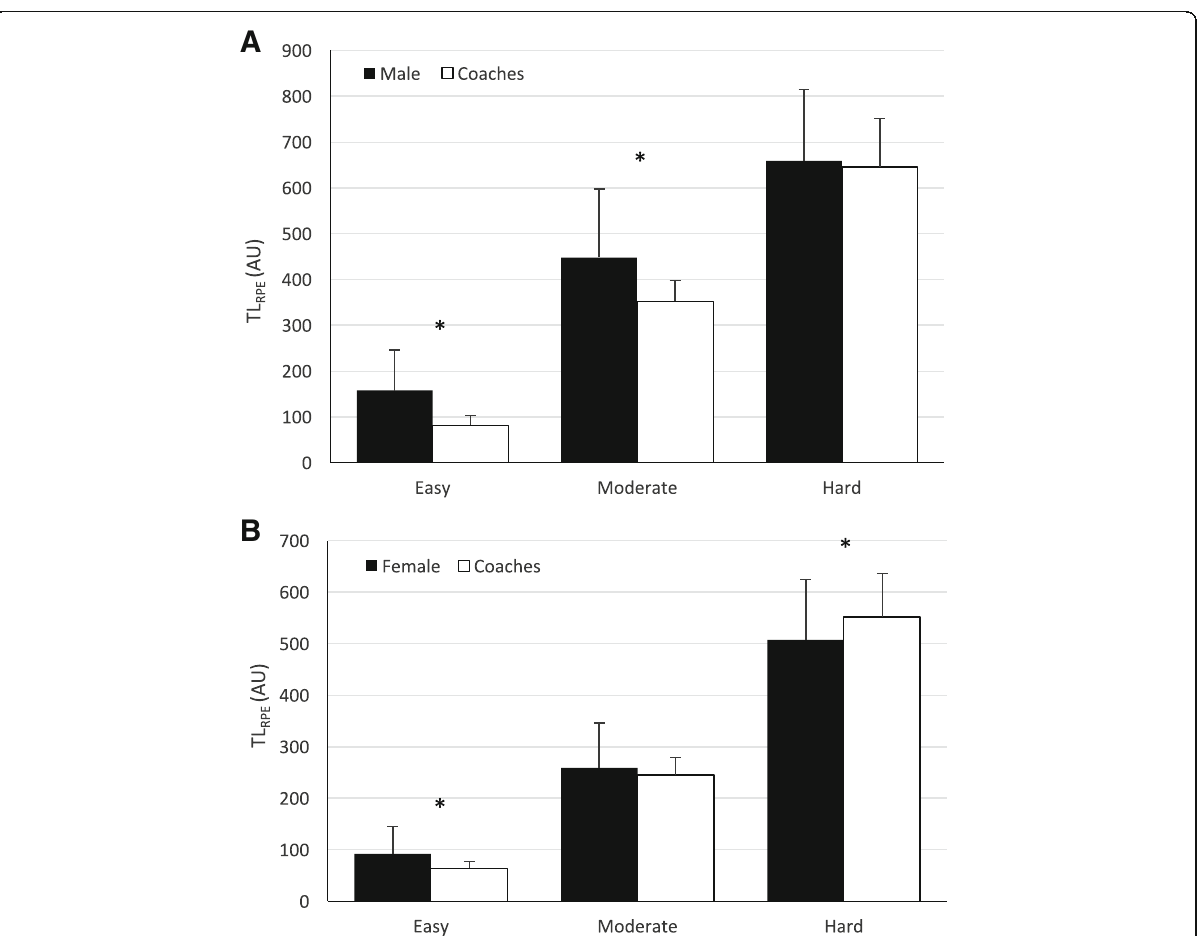
Fig. 1 Comparison of average training load (TL RPE ) between coaches and male runners ( a ) and between coaches and female runners ( b ) for easy, moderate, and hard training sessions throughout the cross-country season. AU arbitrary units; asterisk indicates significantly different, p <